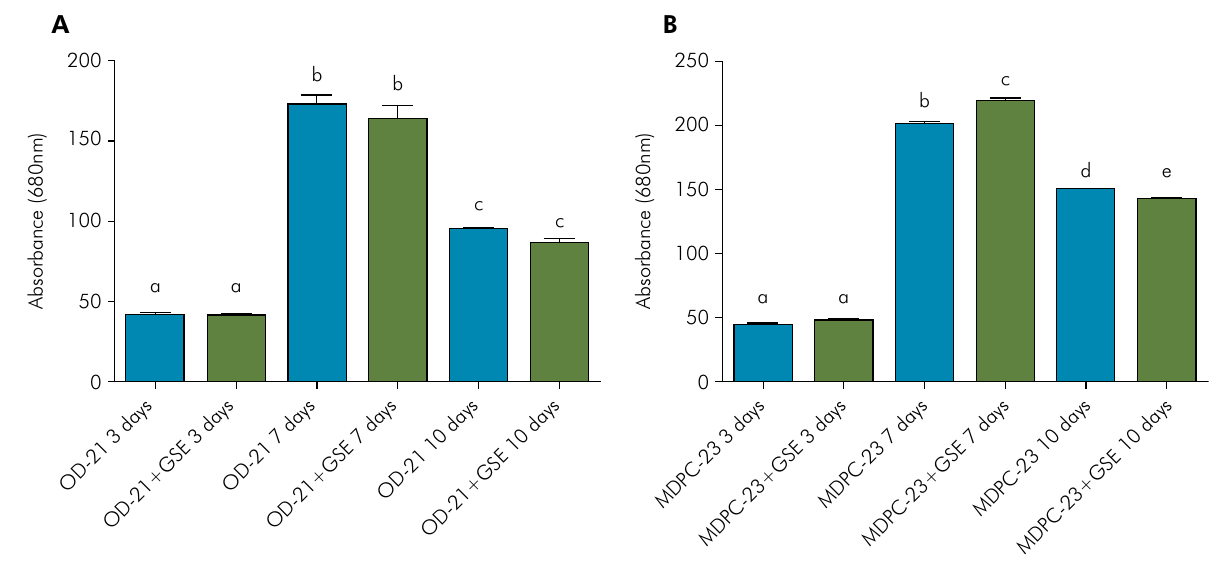
Figure 2. OD-21(A) and MDPC-23(B) total protein content after 3, 7 and 10 days. Different letters mean statistical difference set at 5%